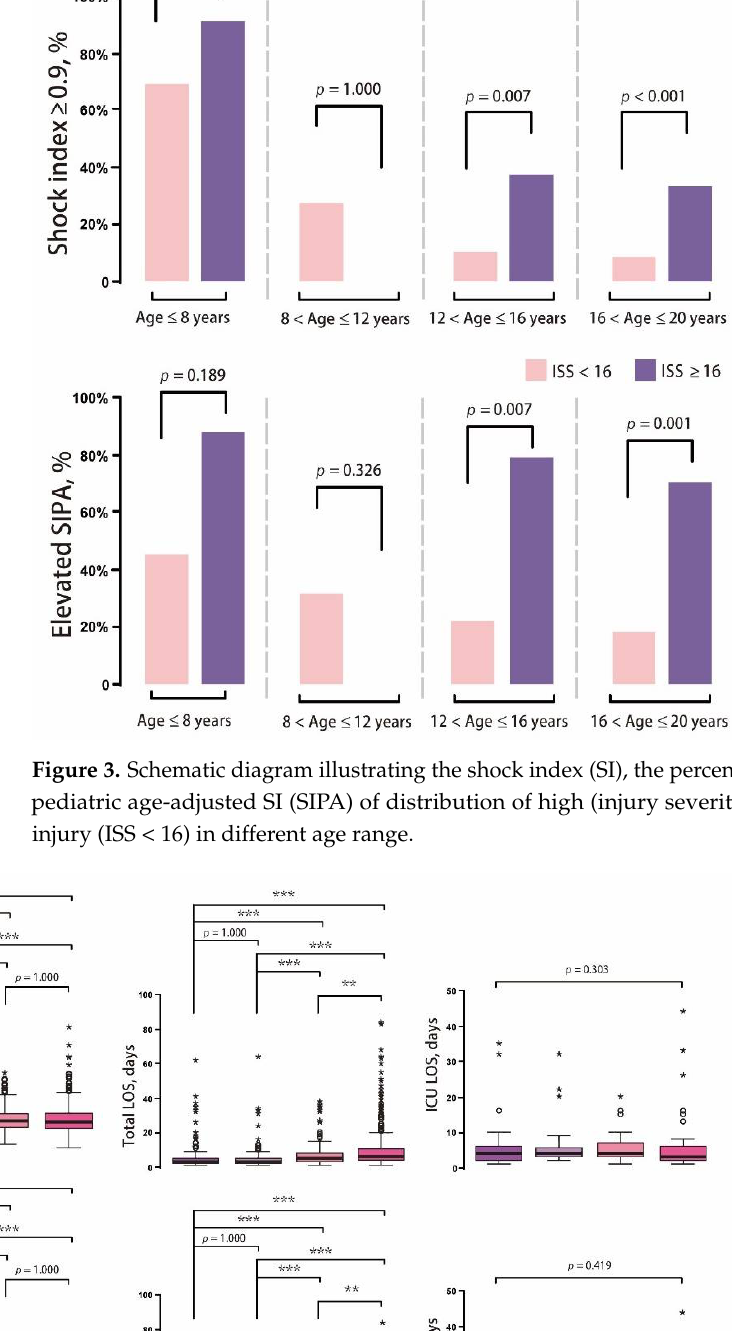
Figure 4. The distribution of shock index, total length of stay (LOS), and intensive care unit (ICU) LOS in different age in high (injury severity score, [ISS] ≥ 16) and low injury (ISS < 16). Figure 5. The area under the receiver operating characteristic curve (AUROC) of shock index > 0.9 and elevated pediatric age-adjusted SI (SIPA) predicting mortality, intensive care unit (ICU) admission, and need for surgery in population with age ≤ 16.